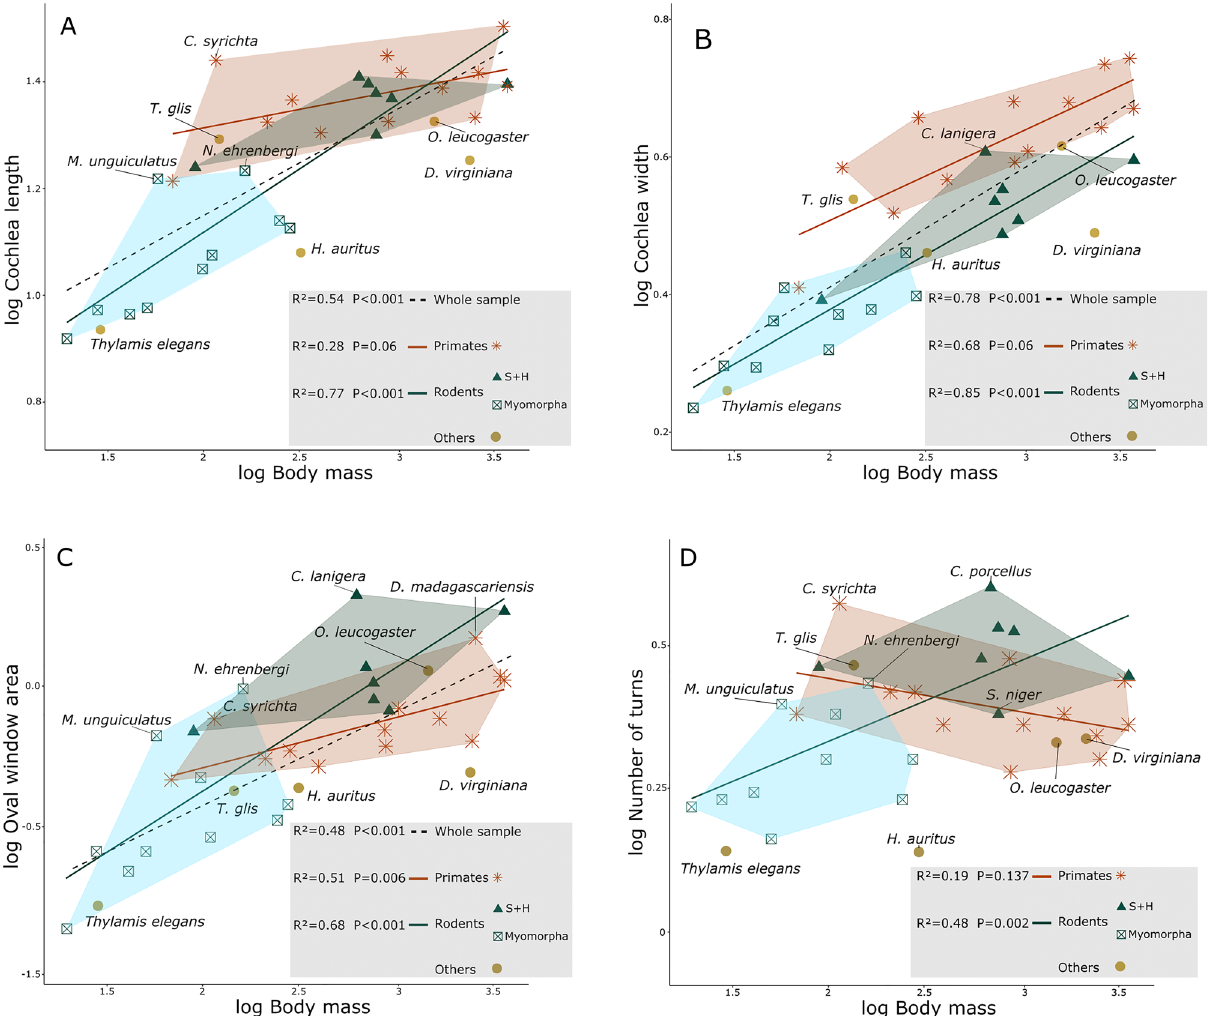
Figure 4. Scatterplots of four selected morphological variables plotted against body mass. ( A ) Cochlea length. ( B ) Cochlea width. ( C ) Oval window area. ( D ) Number of turns. Regression values were obtained by building PGLS models. S + H: Hystricomorpha and